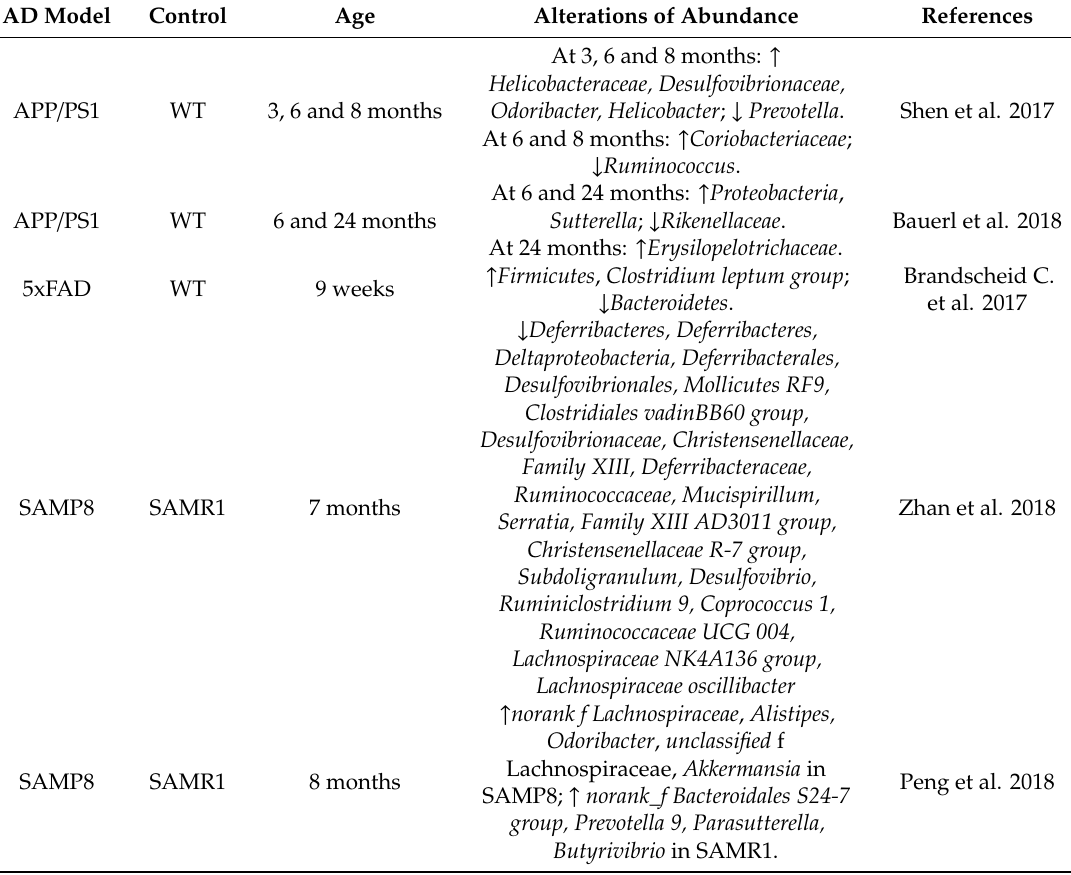
Table 2. Gut microbiota alterations in AD